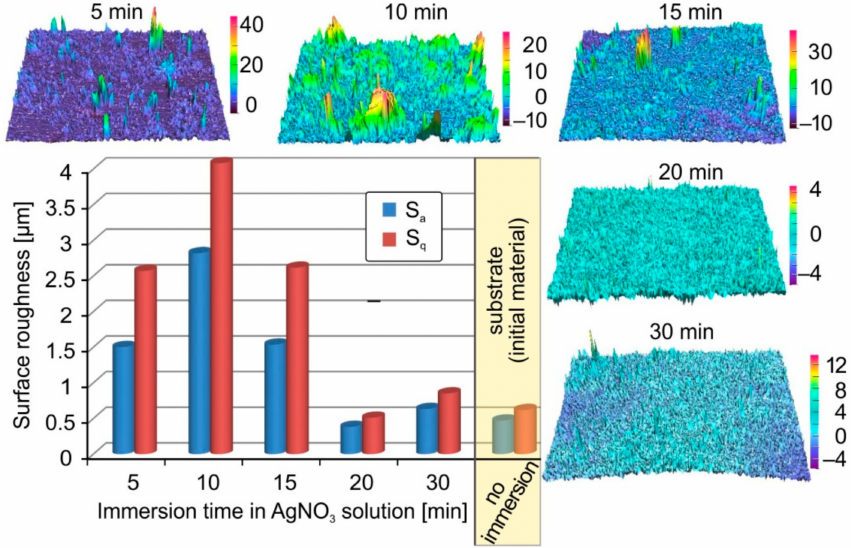
Figure 4. Surface roughness of silver-coated copper samples relative to the immersion duration in silver nitrate solution (using pH 10 for the Tris buffer solution) along with corresponding 3D imaging of surface